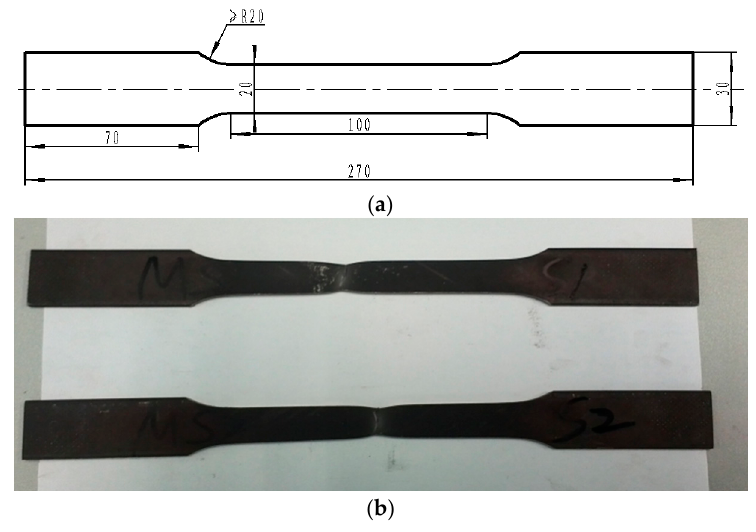
Figure 4. Shape and dimensions of the tensile specimen and the fractured specimens: ( a ) Shape and dimensions of the tensile specimen; ( b ) fractured specimens. Table 2. Property parameters of high-strength steel B550CL.